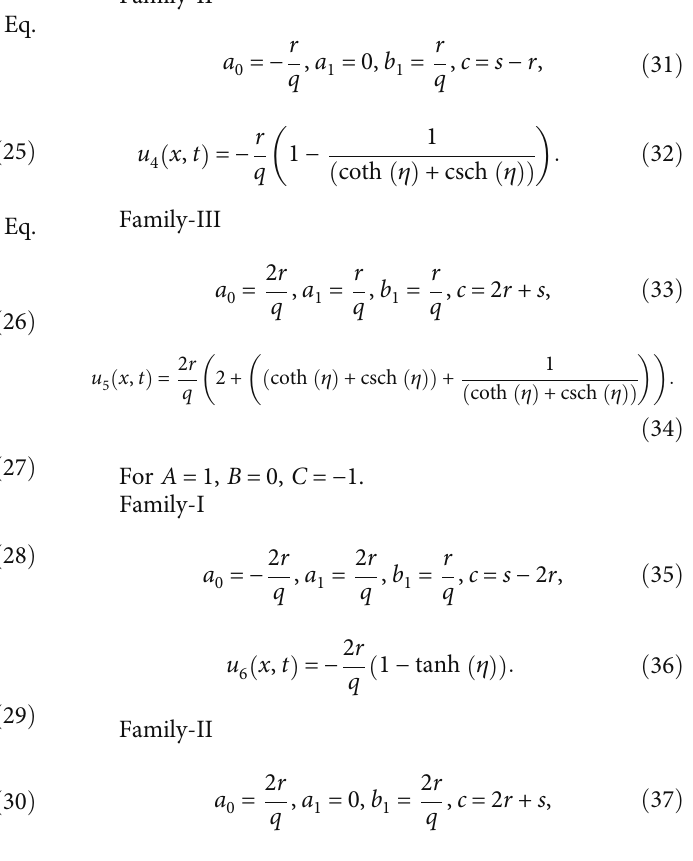
Figure 2: 2D and 3D graphics for hyperbolic traveling wave solution (26) at f β = 0 : 5, r = 1, q = 1, c = 1 g .